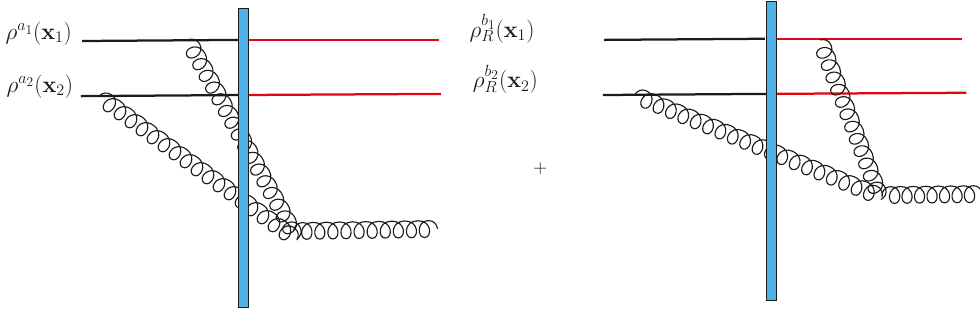
Figure 7 . Schematic representation of the color structure for the second term in β (3) ( τ, k ) . The shaded bar represents the target nucleus. The eikonally rotated color charge density ρ sented using red